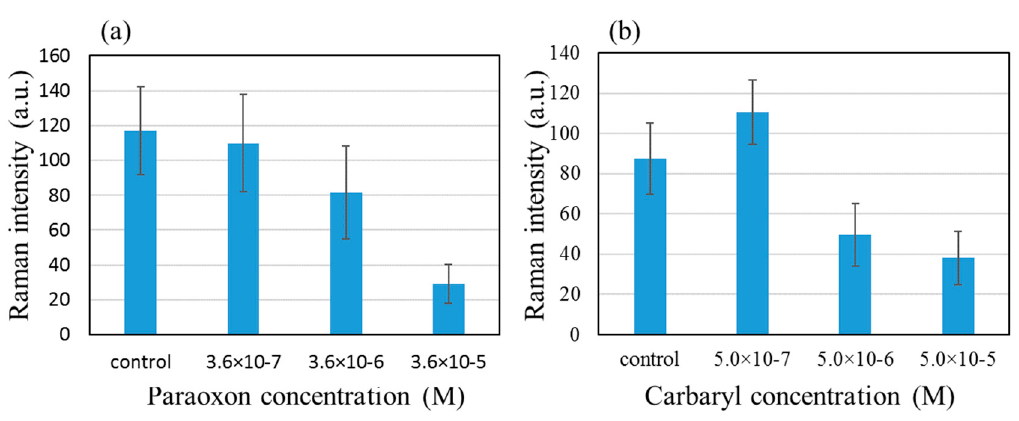
Figure 5. Loss in the intensity of the 768 cm − 1 peak with addition of increasingly higher concentrations of ( a ) paraoxon and ( b ) carbaryl.